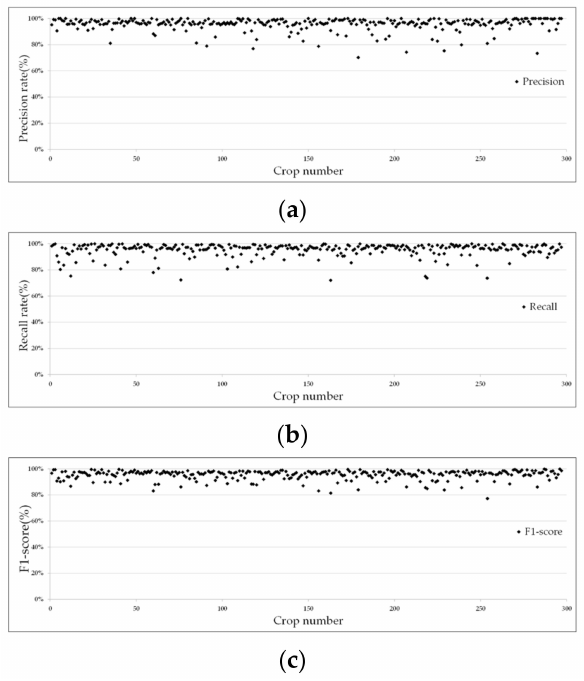
Figure 12. Individual maize segmentation accuracy; ( a ) Precision rate; ( b ) Recall rate; ( c ) F1-score . Figure 11 depicts the target individual segmentation preview. We render TP , FP , and FN as yellow, red, and blue, respectively, and display them in the same coordinate